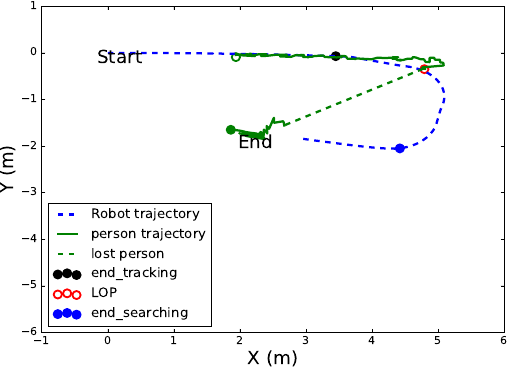
Figure 12. Robot and person trajectories in the world coordinate (2D) for three